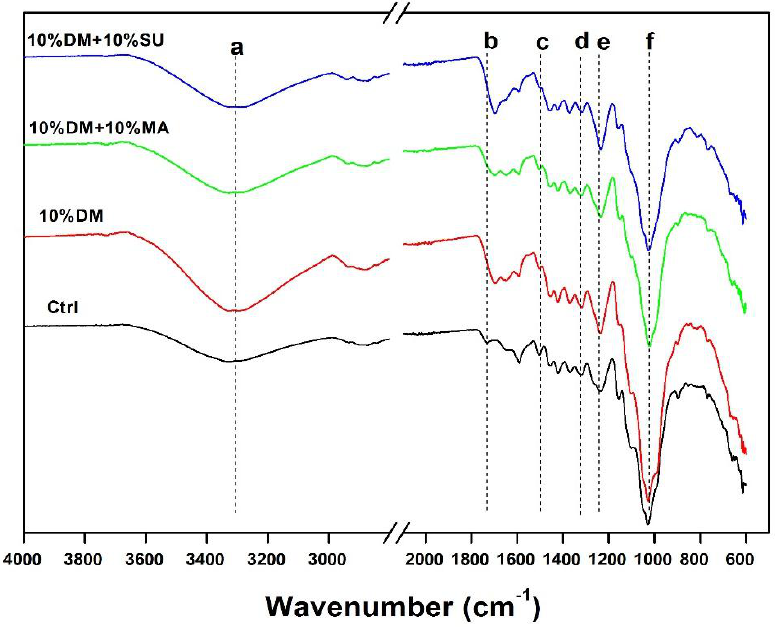
Figure 8. Fourier-transform infrared (FTIR) spectra of samples treated with 10% DM, 10% DM and MA and SU at different concentrations, and untreated wood powder. Band assignments: ( a ) O-H bending; ( b ) carbonyl stretching in wood and DM; ( c ) aromatic skeletal vibration in lignin; ( d ) C-O stretching in lignin and hemicellulose; ( e ) C-O stretching in lignin and acetyl and carbonyl vibration in hemicellulose, as well as C-O vibration at the N-methylol group of DM; and ( f ) C-O stretching in alcohol and ether groups of polysaccharides and lignin.